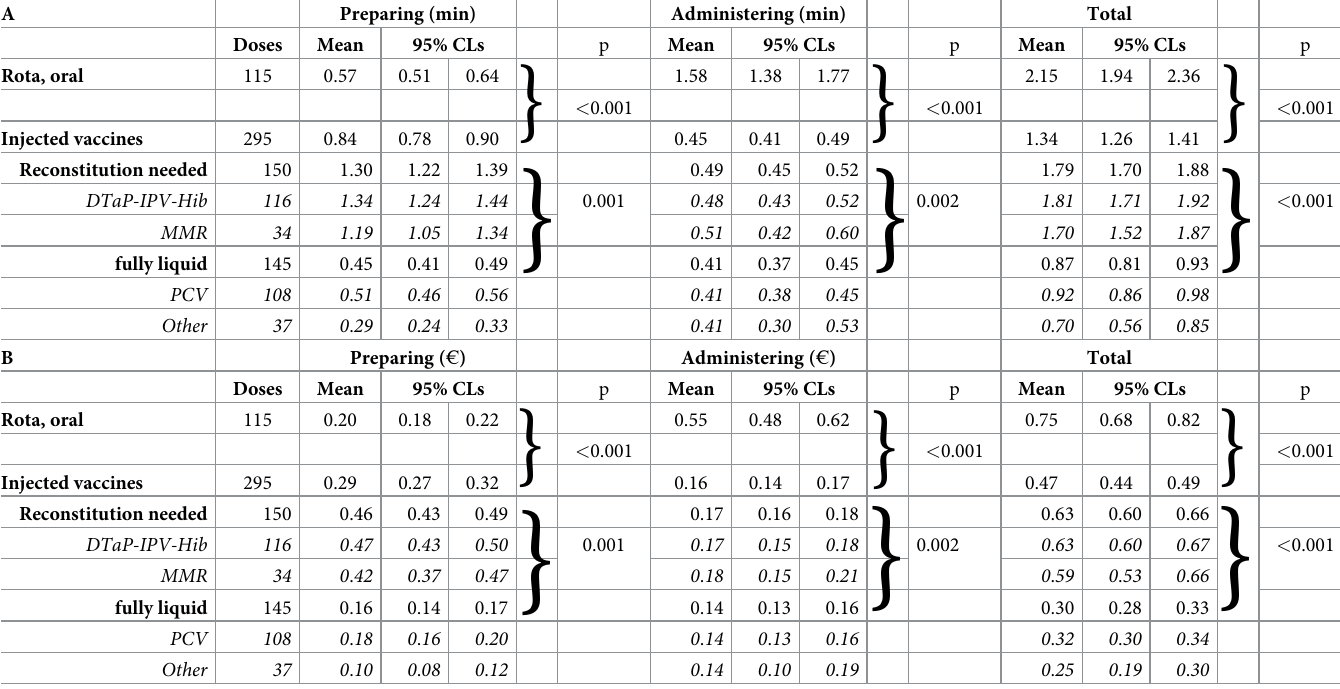
Table 5. Observed time in minutes (A) and labour costs in Euros (B) used for preparing and administering different